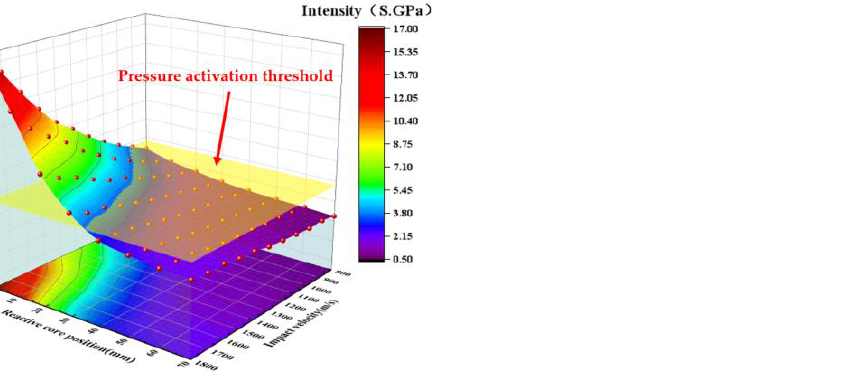
( d ) Figure 8. Warhead deformation and fragment distributions after penetrating RHA steel target at different impact velocities: ( a ) v 0 = 800 m/s, ( b ) v 0 = 1200 m/s, ( c ) v 0 = 1400 m/s, and ( d ) v 0 = 1600 m/s. 3.2.2. Results and Discussion The damage status of the double-layer aluminum target at two typical velocities is shown in Figure 9. The perforation produced by the 1# aluminum target in Figure 8a was relatively flat, and the reaming effect was not evident. Only the 2# aluminum target had evident irregular petal-like perforations, and some pits, small holes, and other debris ap- peared near the perforation. As shown in Figure 8b, after the impact velocity was greater than 1200 m/s, the 1# aluminum target showed a significant reaming effect. The petal-like perforation diameter and damage area were significantly increased when they compared to how they were before. More target plate fragments formed, and the perforation diam- eter of the 2# aluminum target also increased. However, the damaged area showed a trend of increasing first, and then decreasing.